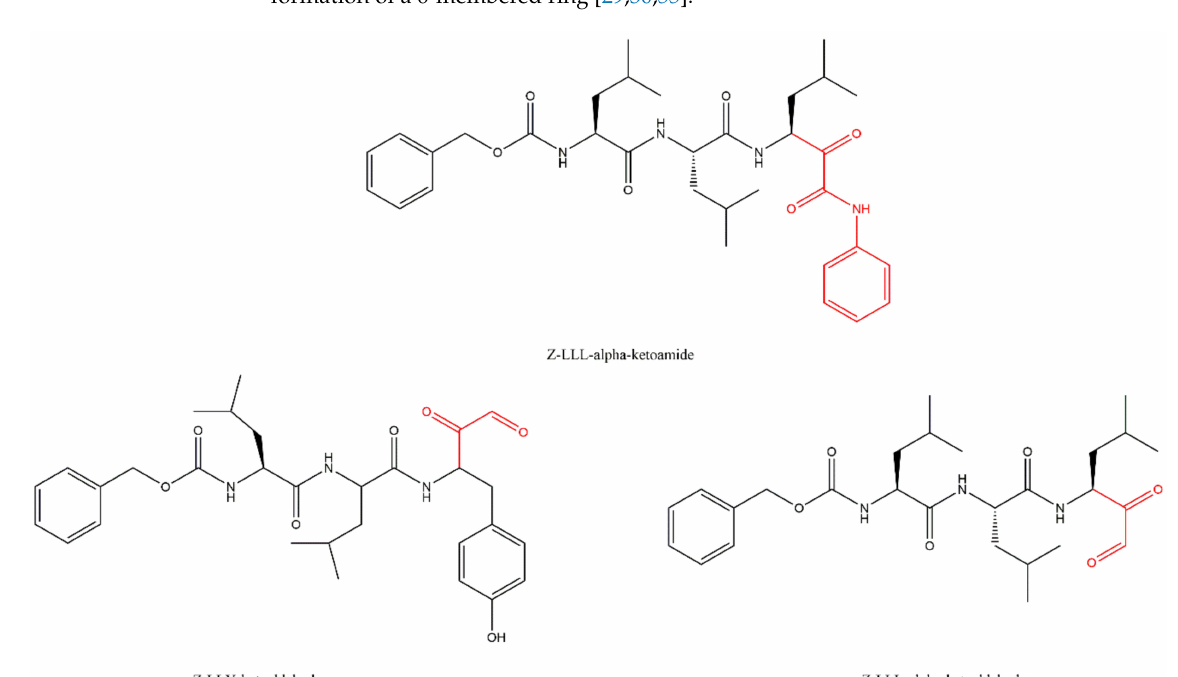
Figure 14. Examples of α -ketoaldehyde (Z-LLL- α -ketoamide) and α -ketoamide (Z-LLY-ketoaldehyde and Z-LLL- α -ketoaldehyde) inhibitors. Adapted from: